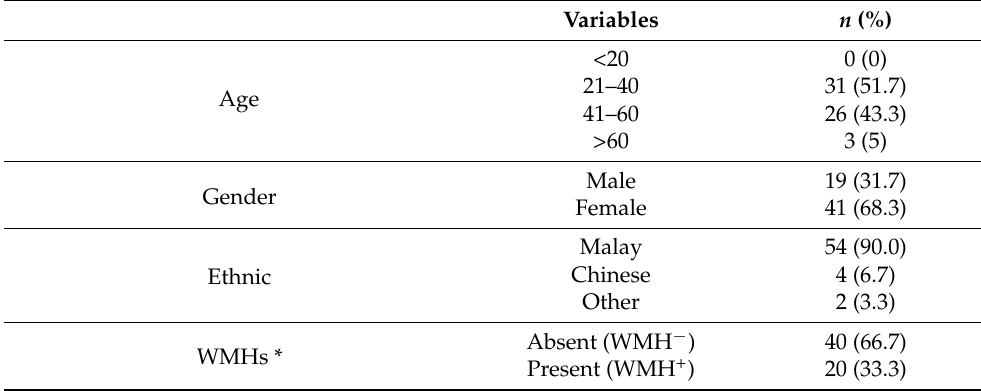
Table 1. Distribution of demographics variables in the study ( N = 60, mean age = 39.83 ± 11.50